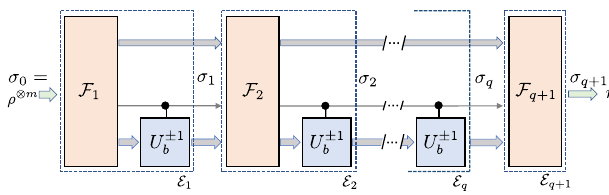
FIG. 1. The quantum operation E . Arrows denote the states σ j output by the quantum operations E j and used as the input to the following E j + 1 . The input state σ 0 contains m copies of a state ρ . The output state σ q + 1 contains the bit r